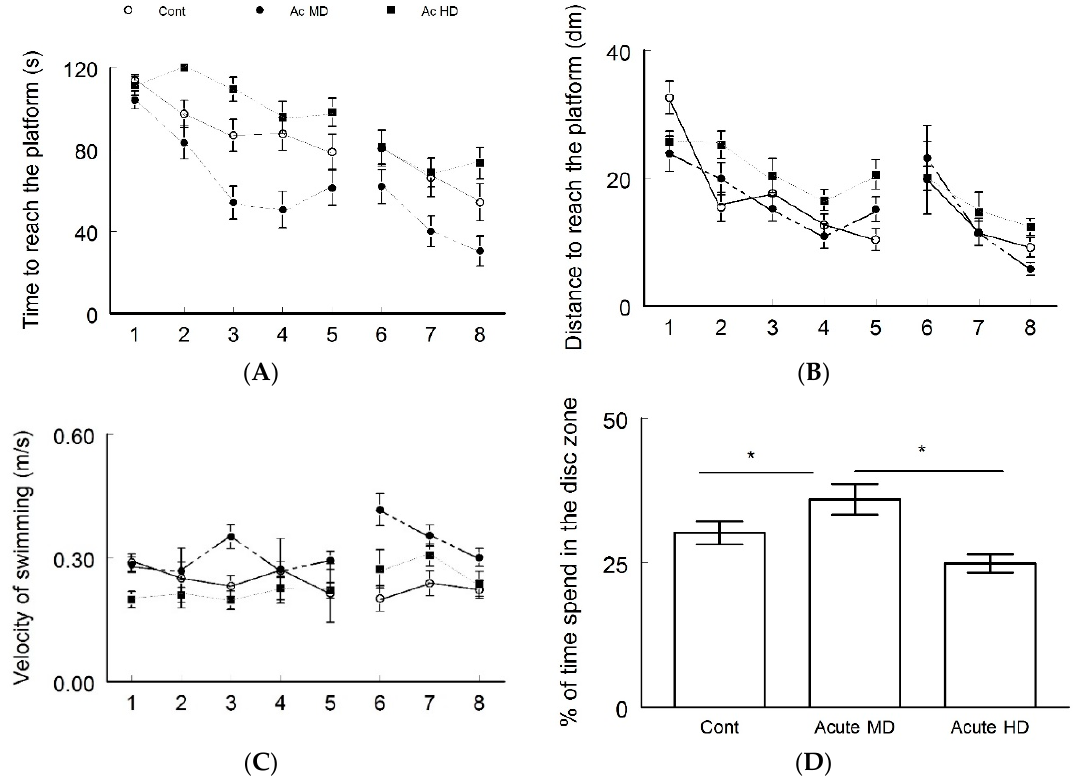
Figure 2. Morris water maze test used to assess cognitive function of the control, moderate dose, and high dose groups. ( A ) Time (latency) to reach the platform; ( B ) Distance to reach platform; ( C ) Velocity of swimming (m/s); and ( D ) % of time spent in the disc zone (Probe Test). In all the parameters tested, the Ac MD group showed better results than the other groups (ANOVA Test, p < 0.05).